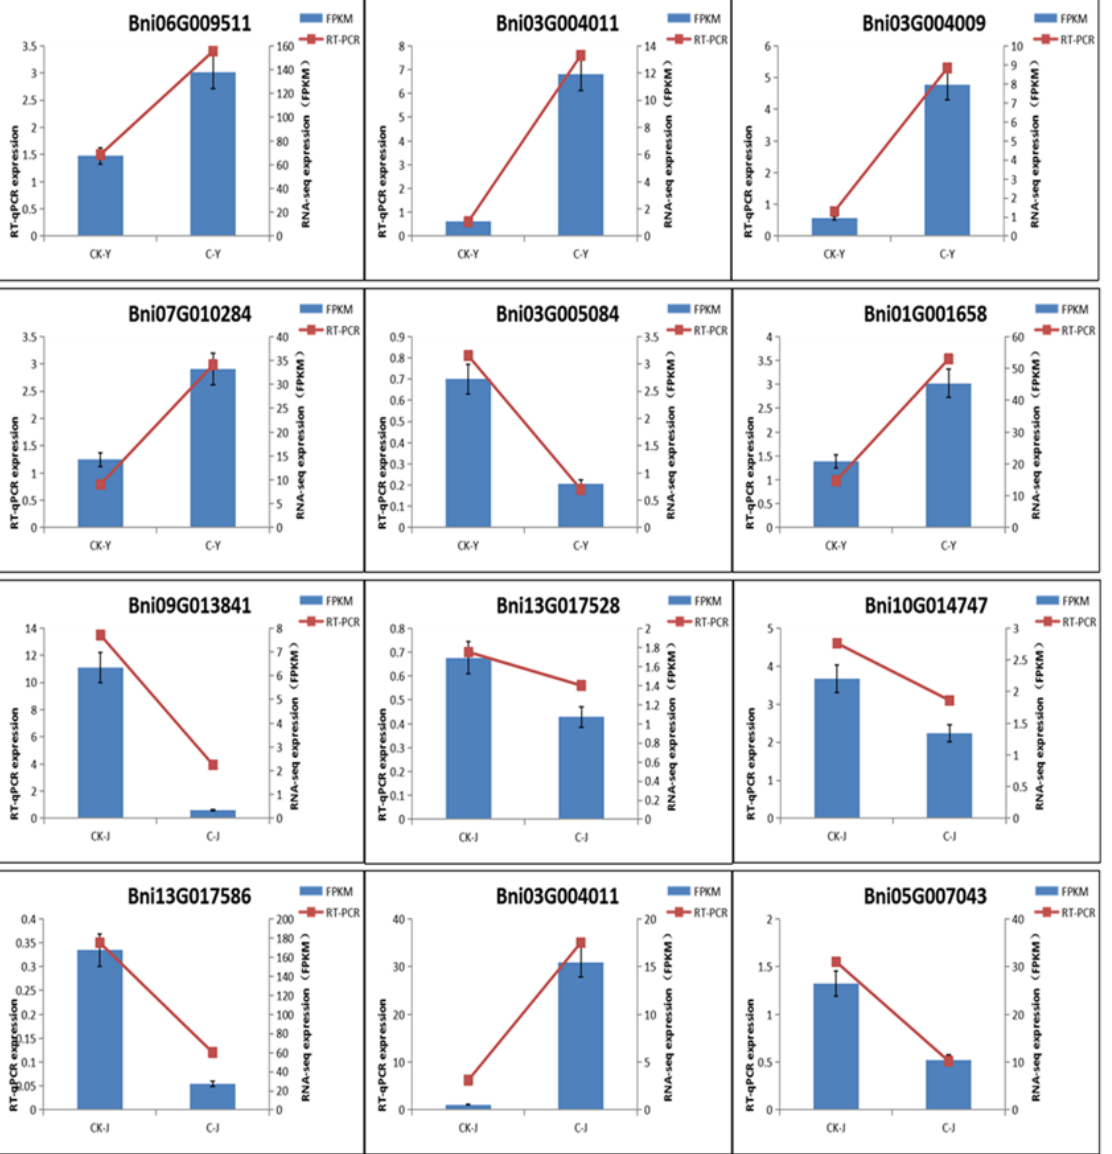
Figure 6. Validation of the Differentially Expressed Genes (DEGs) in GA 3 and ETH-treated Leaves and Stems. qRT-PCR was Performed for Six DEGs from Leaves and the Other Six from Stems. The results from both FPKM and qRT-PCR were consistent.